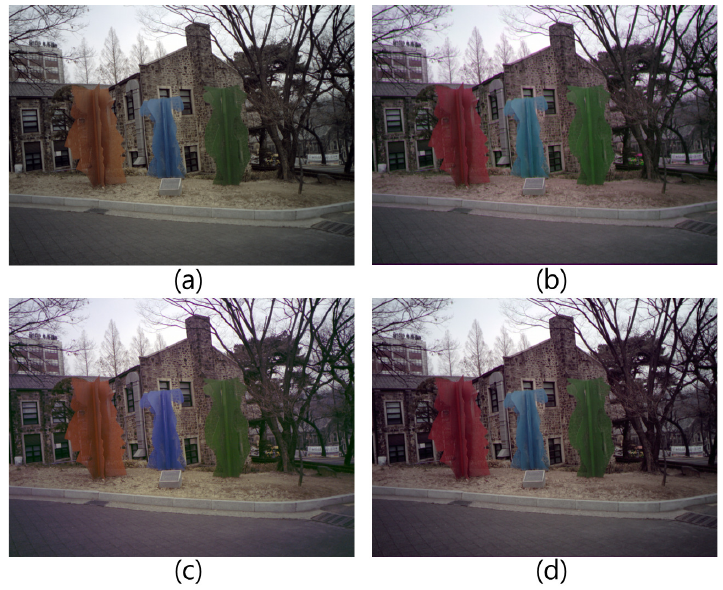
Figure 11. Experimental results (sunlight): ( a ) RWB image before RGB color conversion; ( b ) RGB color image; ( c ) 3 × 3 CCM; and ( d ) Proposed